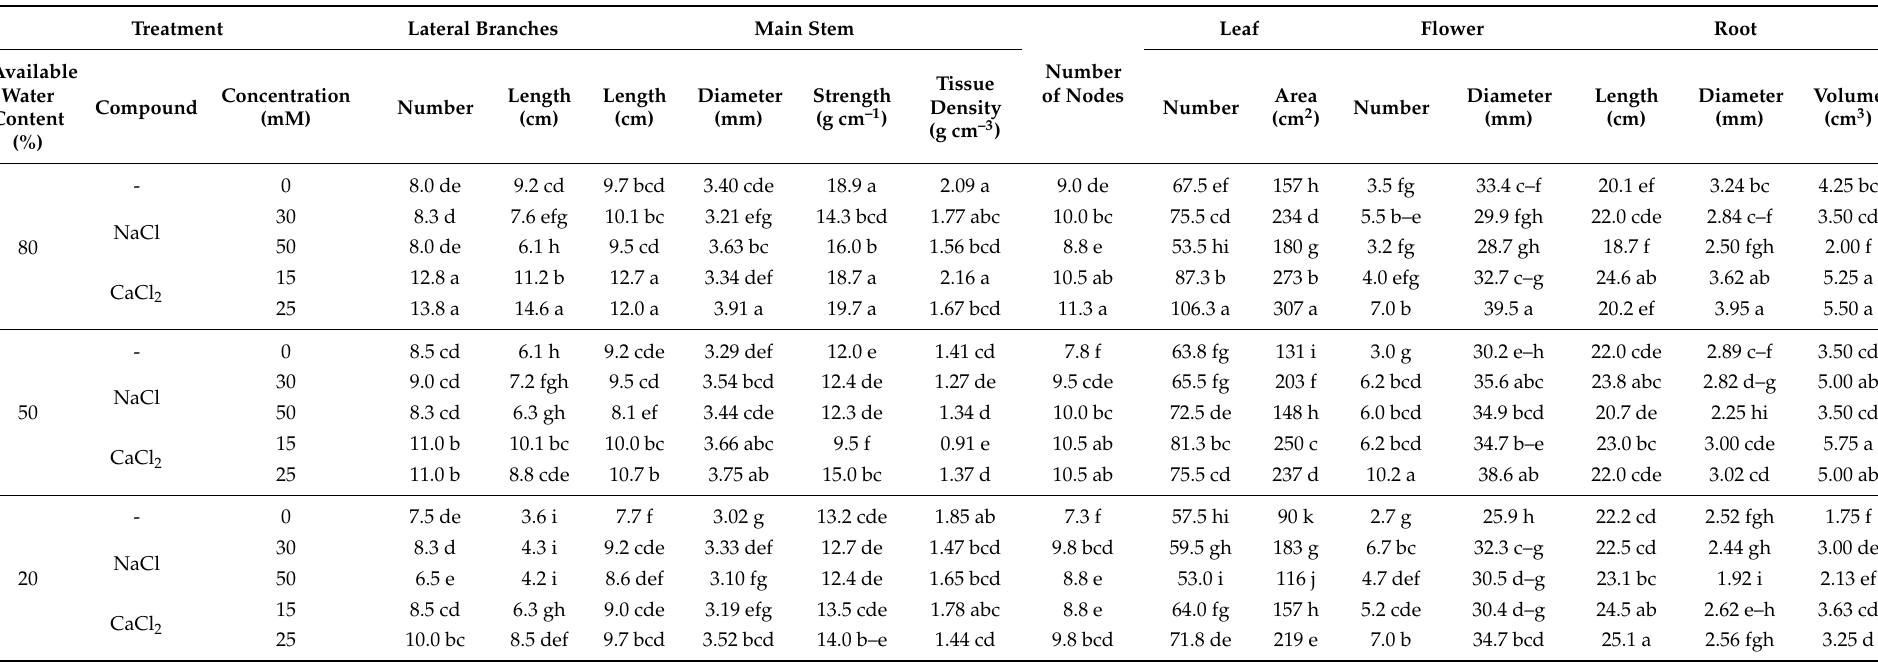
Table 2. Morphological features of periwinkle cv. ‘Pacifica XP Really Red’ plants initially receiving NaCl (0, 30 and 50 mM) or CaCl 2 (15 and 25 mM) via irrigation (five applications at 3 d intervals), and subsequently exposed to different watering levels (80, 50 and 20% available water content) during cultivation. At first application, plants were at the four-leaf stage. Means followed by different letters indicate significant differences ( p = 0.05; comparison in columns). Values are the mean of four